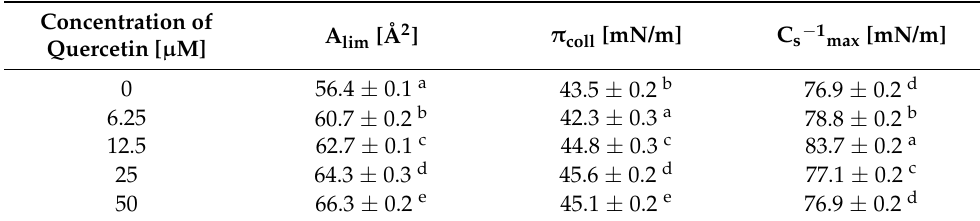
Figure 3. Surface pressure isotherms and corresponding compressibility modulus (inset) of the lipid model of neuroblastoma layers spread on the subphase contained the indicated concentrations of quercetin dissolved in buffer. Table 2. Surface parameters of monolayers (A lim –the limiting area per one molecule; π coll –collapse pressure; C s − 1 –maximal values of compression modulus) calculated for monolayers of the model of neuroblastoma membrane. Data represent mean from three experiments ± SD. Different letters indicate significant differences ( p ≤